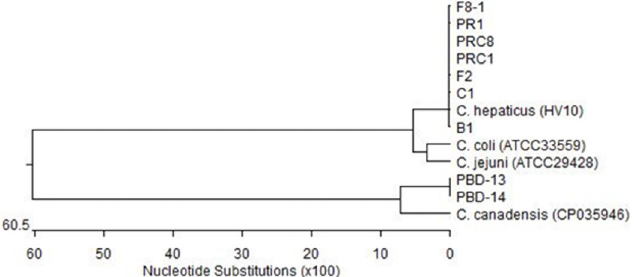
Fig 6. Phylogenetic analysis of hsp60 gene sequences (269–272 bp) from Campylobacter species isolated from chickens (F8-1, PR1, PRC8, PRC1, F2, C1 and B1) and wild birds (PBD-13 and PBD-14). Sequences were compared with those of Campylobacter reference strains. The tree was constructed using the Neighbour-joining method (DNASTAR software).